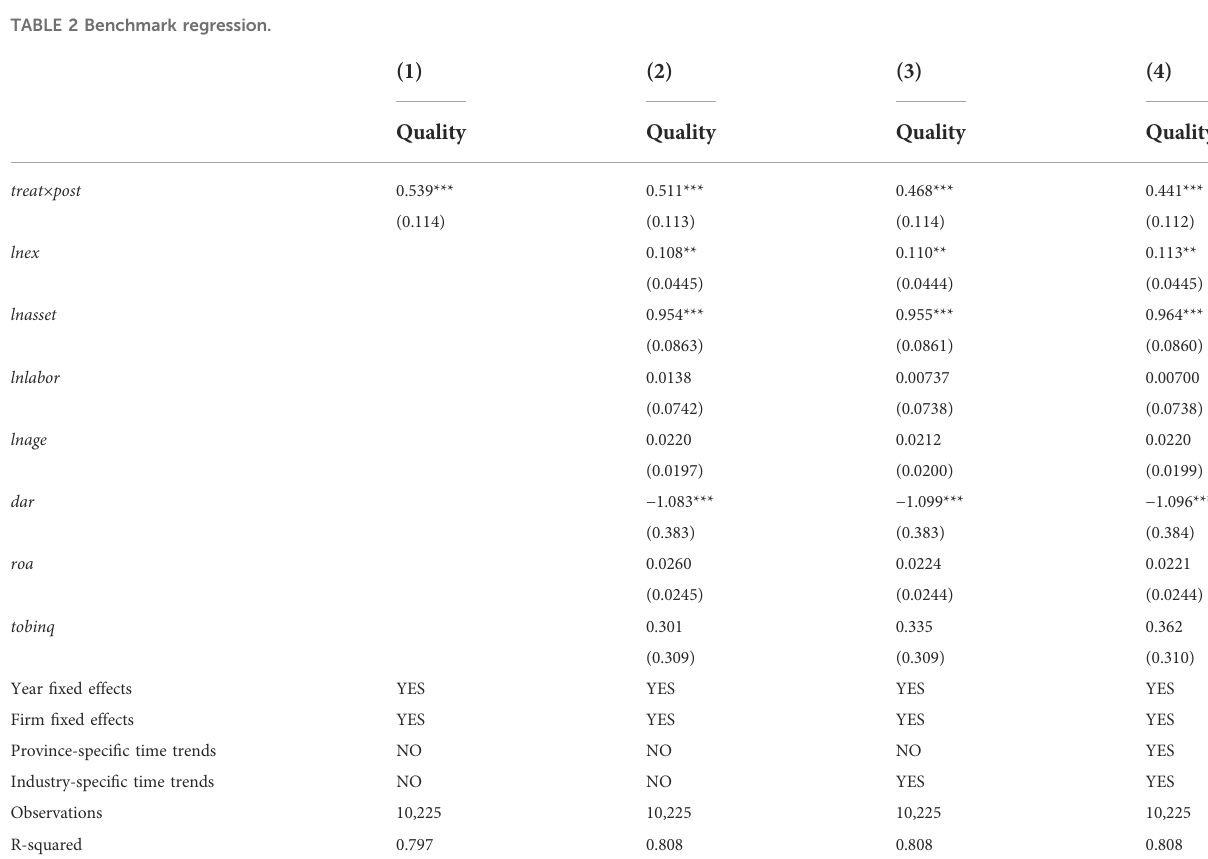
TABLE 2 Benchmark